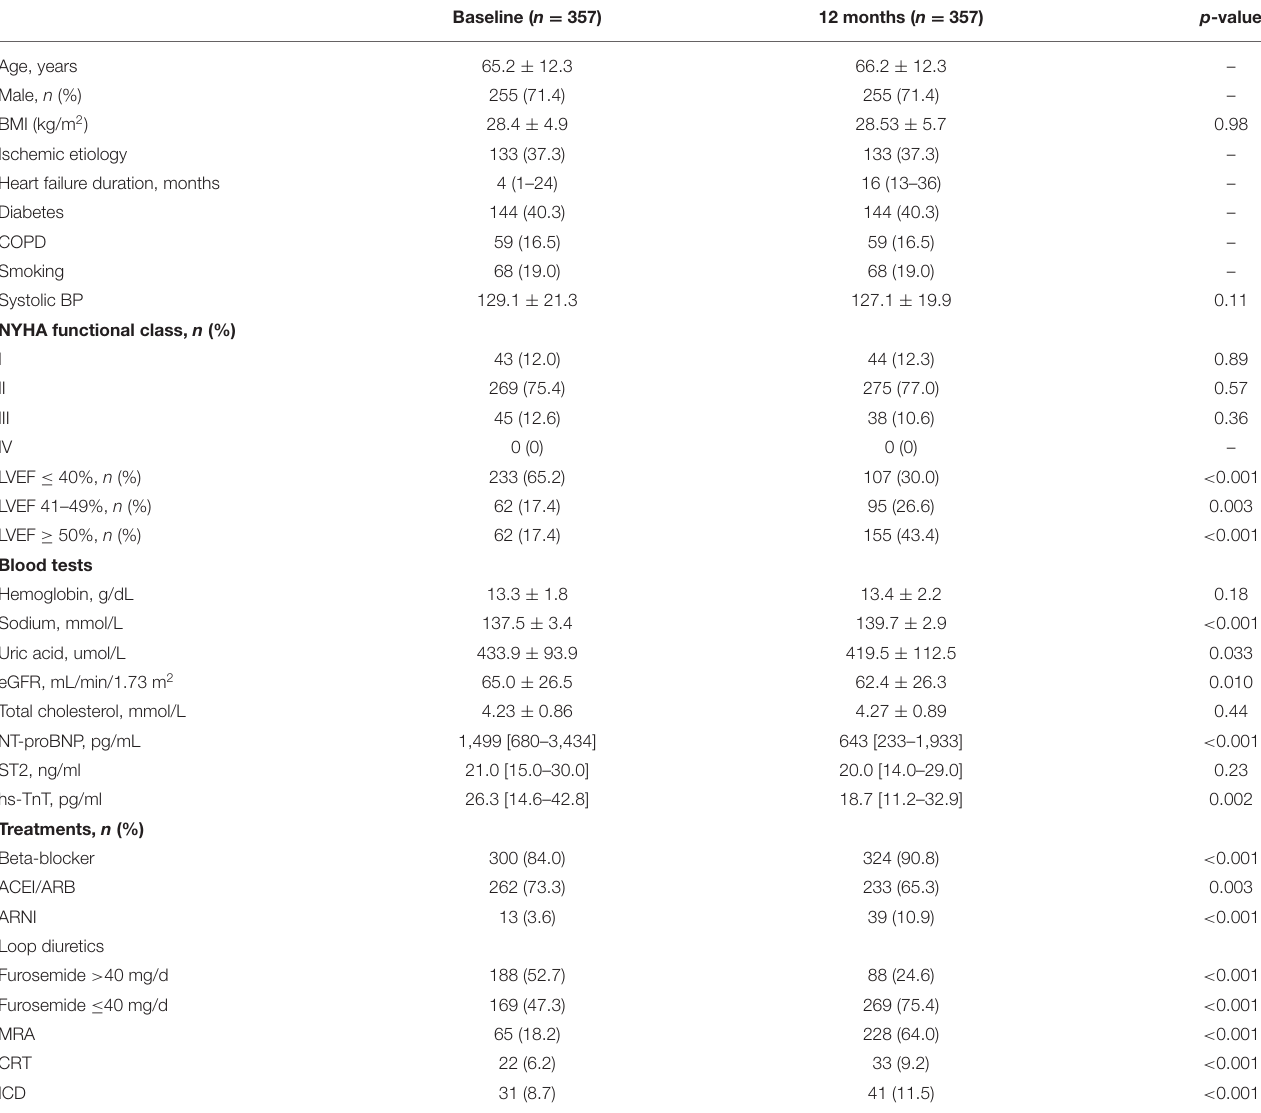
TABLE 1 | Comparison between population characteristics at baseline and after a 12-month management